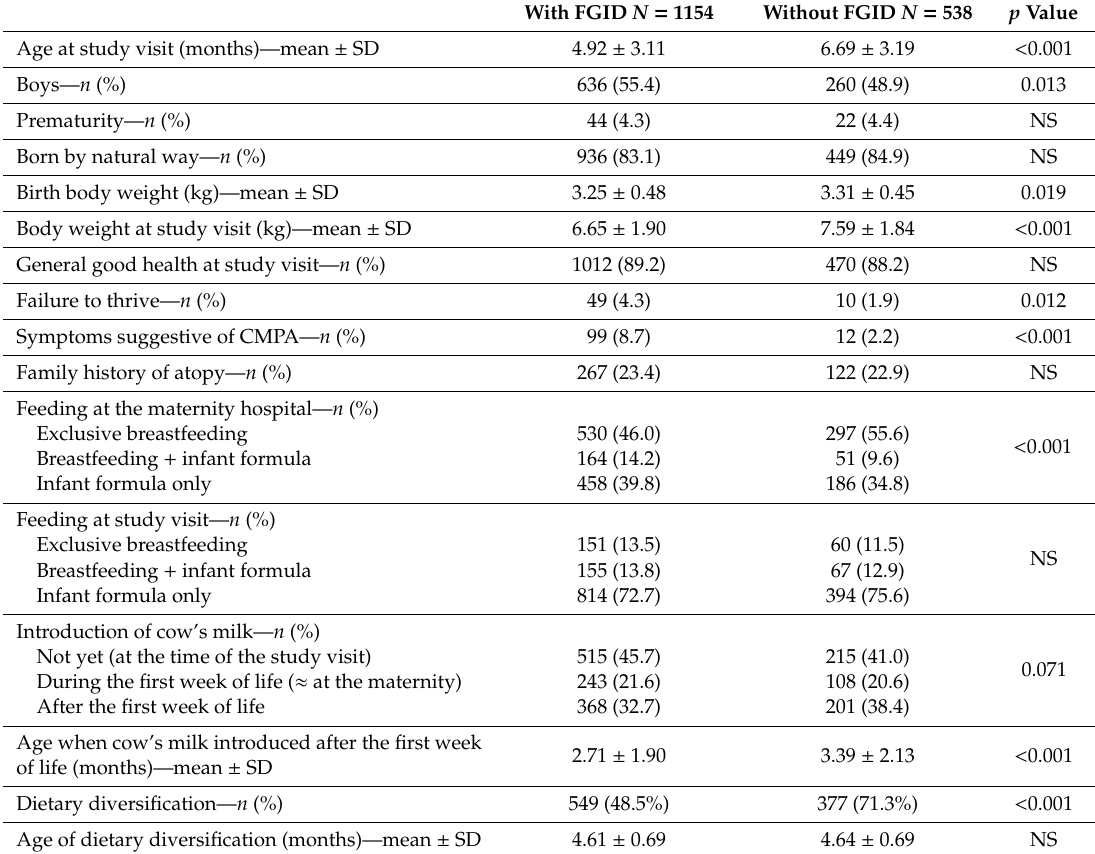
Table 2. Characteristics and feedings of infants with and without functional gastrointestinal disorders ( N = 1722). With FGID N = 1154 Without FGID N =